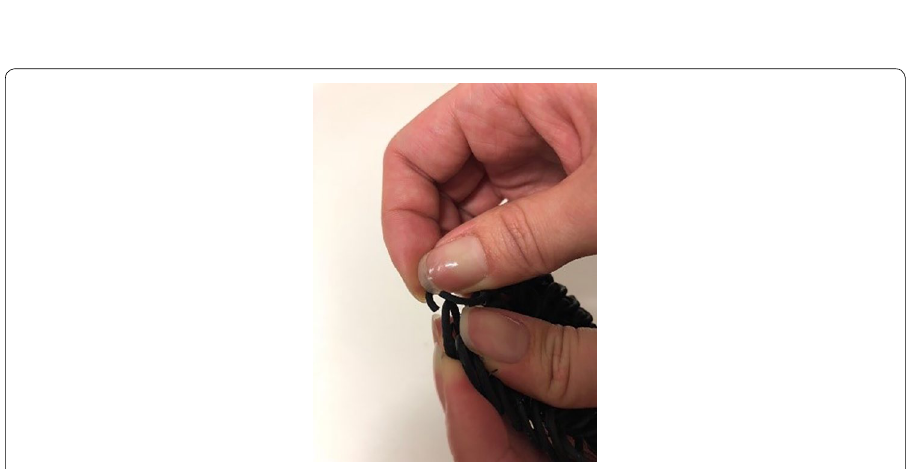
Fig. 19 Method of connecting